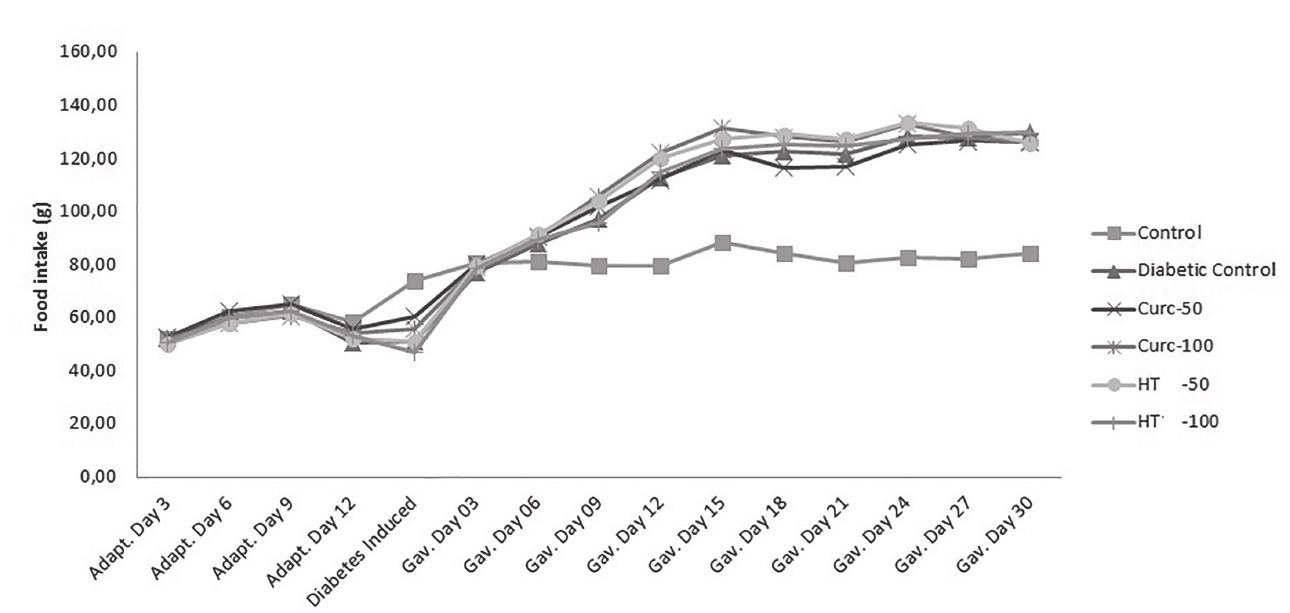
FIGURE 5 - Food intake of the animals throughout experimental period. Adapt. = Adaptation period, measurement of food intake on the indicated days; Gav. = Oral gavage period, measurement of food intake on the indicated days. Control = control group,non- diabetic; Diabetic Control = diabetic control group, diabetic; Curc-50 = group Curc-50, diabetic, curcumin 50 mg/kg of body weight by oral gavage; Curc-100 = group Curc-100, diabetic, curcumin 100 mg/kg of body weight by oral gavage; HTNO group HTNO 50 mg/kg of body weight by oral gavage; HTNO - 50, diabetic, HTNO 2 2 100 mg/kg of body weight by oral